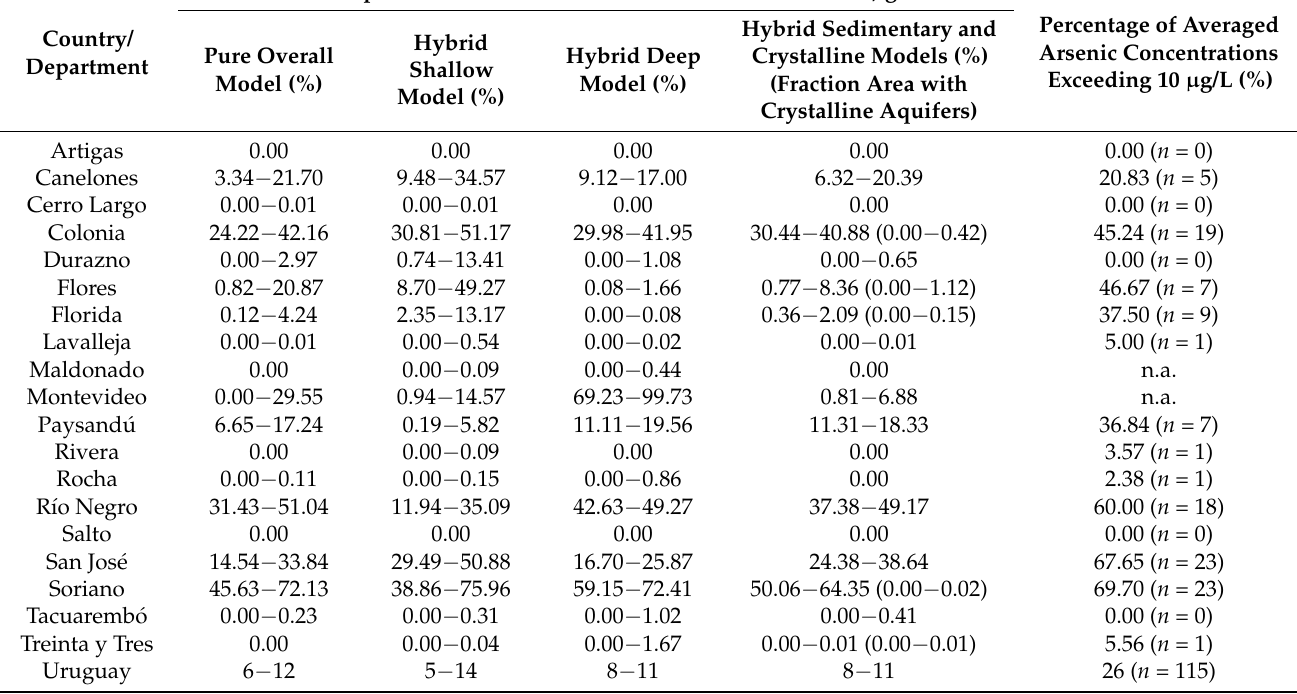
Table 2. Proportion of areas in each department of Uruguay with a high groundwater arsenic hazard: comparison of modelled and observed values. Modelled high groundwater hazard areas were defined as those with a probability of arsenic concentration greater than 10 µ g/L, exceeding a cutoff value of 0.5 and a specific cutoff value where sensitivity is equal to specificity (overall: 0.71; shallow: 0.67; deep: 0.73; sedimentary: 0.63; crystalline: 0.85). Observed values were based on the proportion of high arsenic (>10 µ g/L) in the departments, and the geometric mean of arsenic concentrations was taken within a pixel (1 km 2